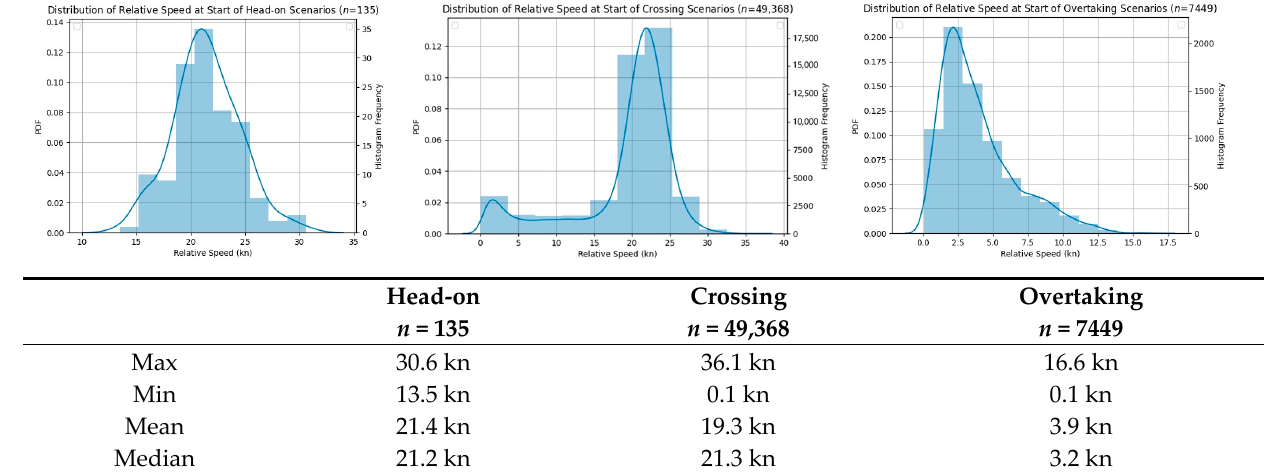
Figure 7. Distribution of relative speed at the start of different encounter scenarios. The numbers indicate the approach speed of OS and TS at the encounter situation being initiated.